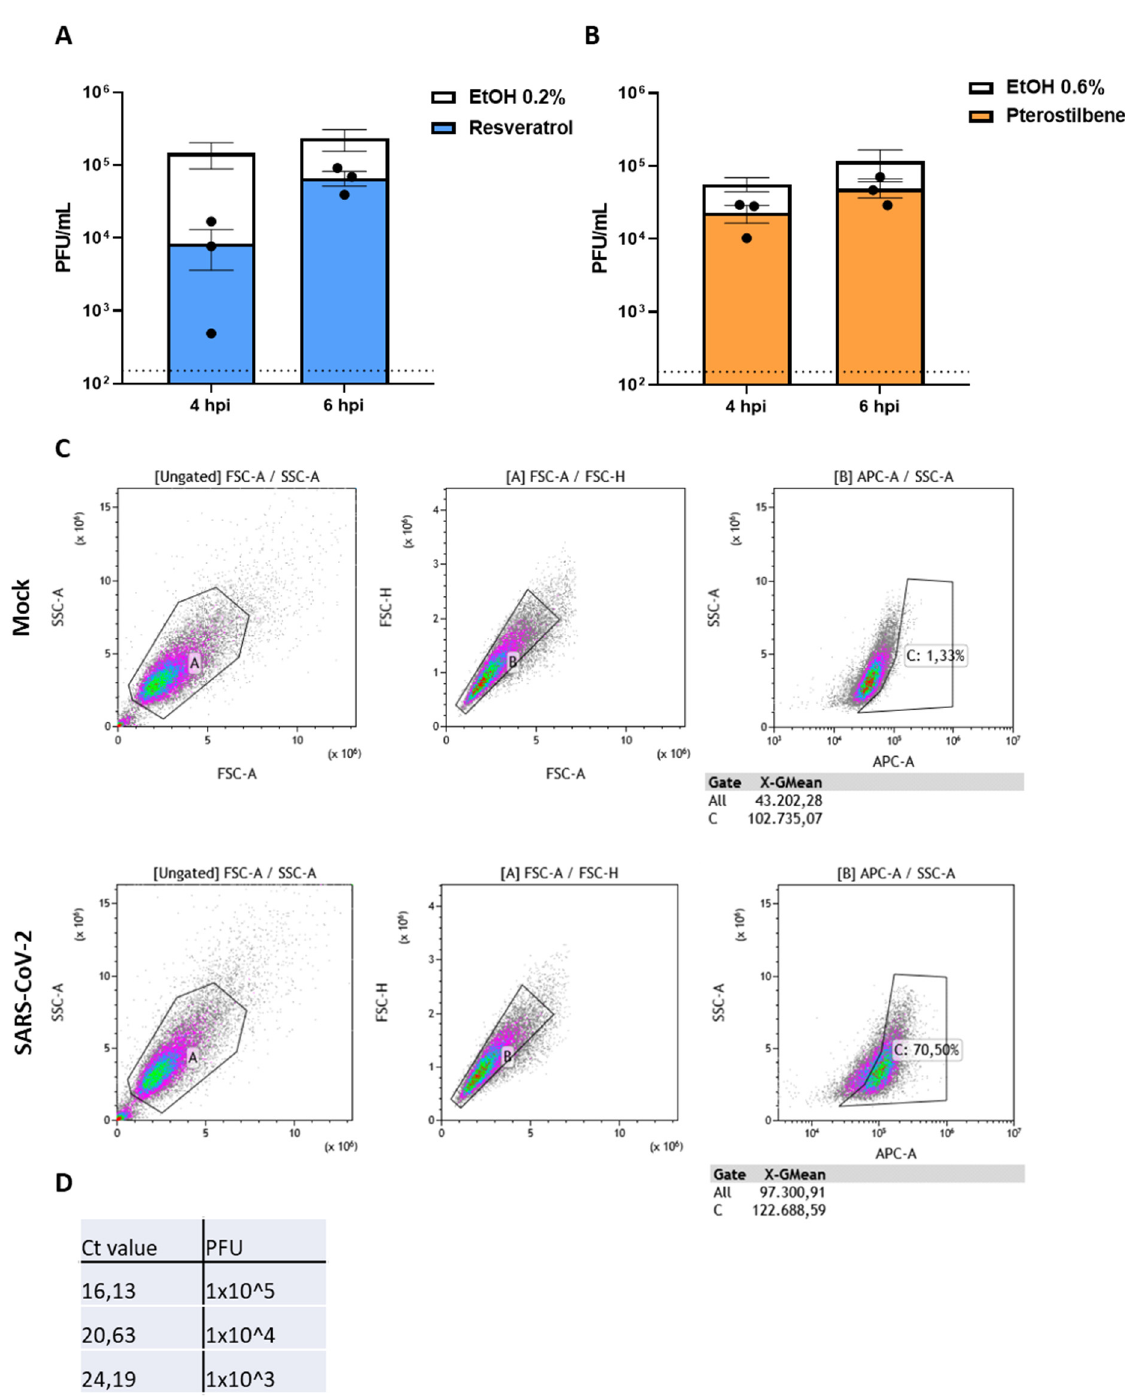
Figure A2. Effect of resveratrol and pterostilbene when added late in the replication cycle of SARS-CoV-2. Vero E6 cells were inoculated with SARS-CoV-2 at MOI 1 and treated with ( A ) 150 µM resveratrol, ( B ) 60 µM pterostilbene, or (A,B) equivalent volumes of EtOH at 4 or 6 hpi. Virus production was determined at 8 hpi via plaque assay. ( C ) Gating strategy flowcytometry NSP8 protein expression. Cell population was gated with gate A; doublets were excluded with gate B; threshold of NSP8 positive population was determined with gate C in the mock condition. ( D ) Ct values referenced to PFU of virus stock determined with Q-RT-PCR for the RdRp gene. Data are represented as mean ± SEM, symbols represent three independent experiments. Dotted line indicates the threshold of detection. Student T test was used to evaluate statistical differences and a p value ≤ 0.05 was considered significant and NS as non-significant.